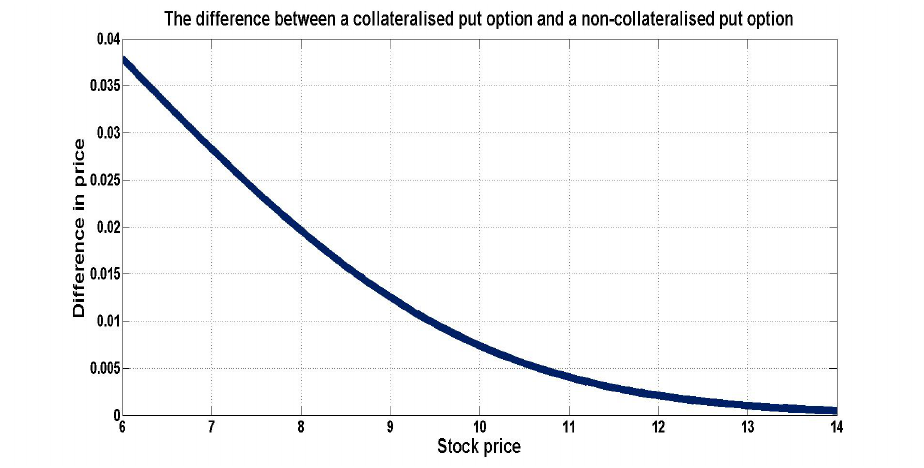
Figure 10. Difference in price between a collateralized European put option and a non-collateralized European put option for various initial stock prices with parameters: S = [8 , 12] , K = 10 , dt = 0 . 0001 (5000 time increments), ds = 0 . 02 , (1000 space 0 = 0 . 04 , r = 0 . 05 , r = 0 . 06 , r = 0 . 01 and σ = 0 . 3 . increments), T = 0 . 5 , r C R F D